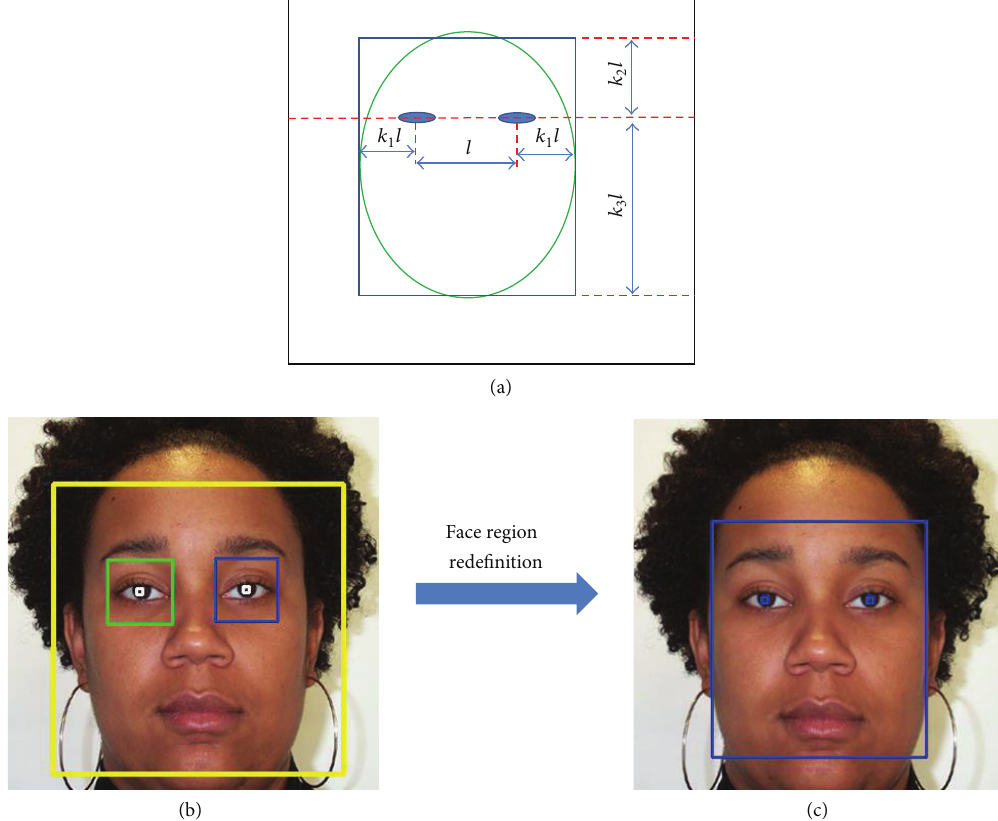
Figure 3: The example of face region redefinition: (a) methodology for face region definition, (b) face region detected using AdaBoost and in-plane rotation compensation, and (c) result of face region of interest (ROI) redefinition. the image texture and extract the feature for age